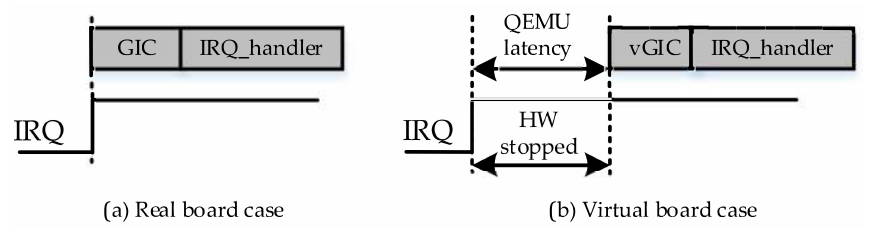
Figure 3. Interrupt management: ( a ) real board vs. ( b ) virtual board